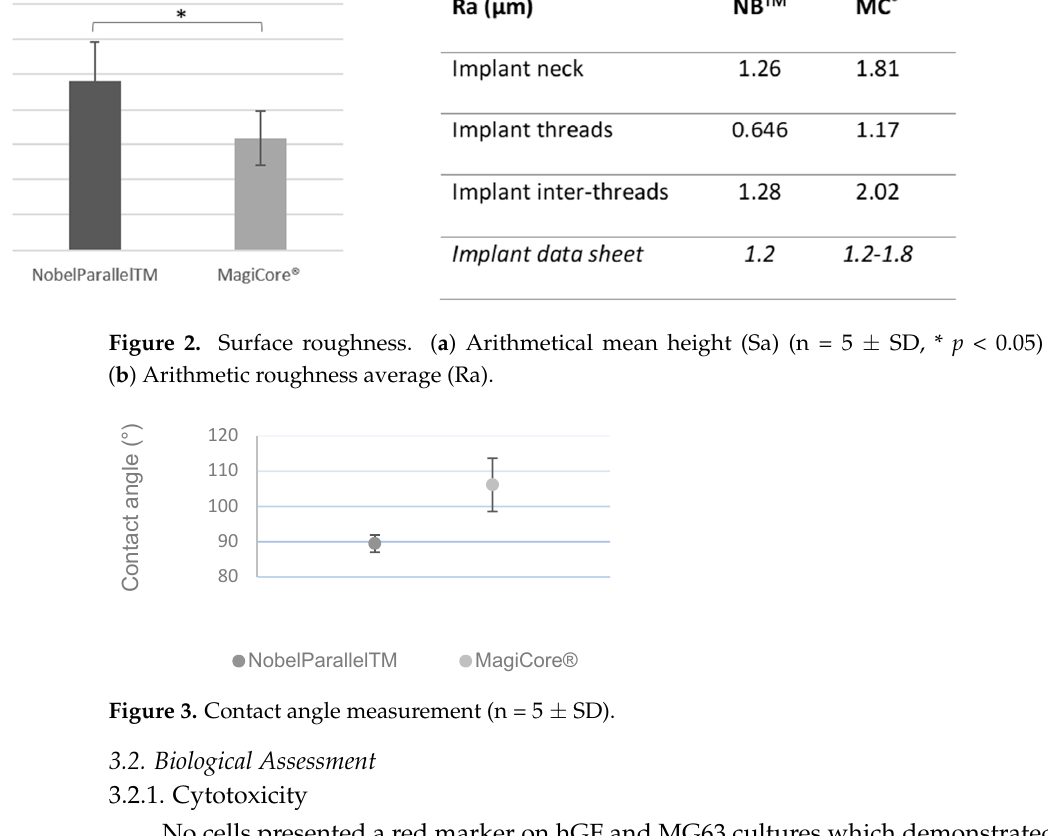
Figure 3. Contact angle measurement (n = 5 ± SD).